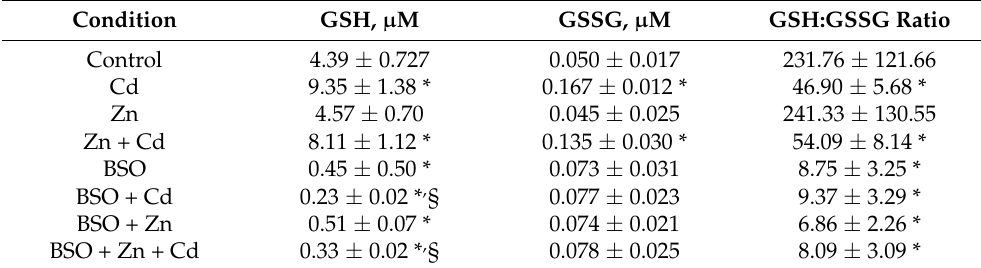
Table 4. Effects of Zinc supplementation and inhibition of glutathione (GSH) synthesis by L - buthionine sulfoximine (BSO) on GSH and glutathione sulfide (GSSG) concentrations and the GSH:GSSG ratio in choroid plexus epithelial cells (CEPCs) exposed for 12 h to 500 nM CdCl 2 . Condition GSH, µ M GSSG, µ